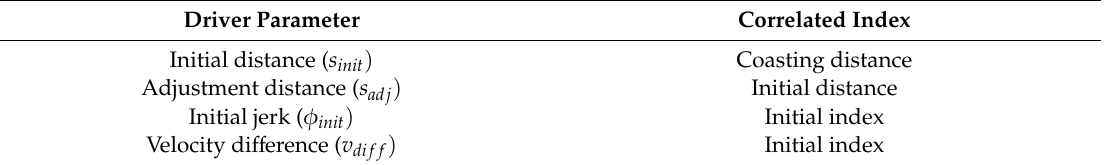
Table 3. Driver parameters and correlated indices.